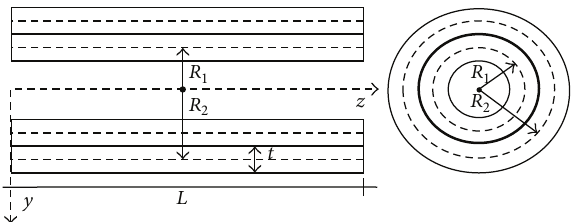
Figure 1: Geometry of double-walled carbon nanotubes (DWC-